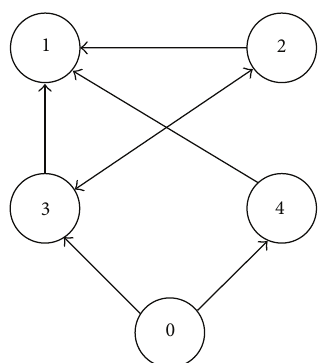
Figure 1: The information exchange topology among all the vessels.